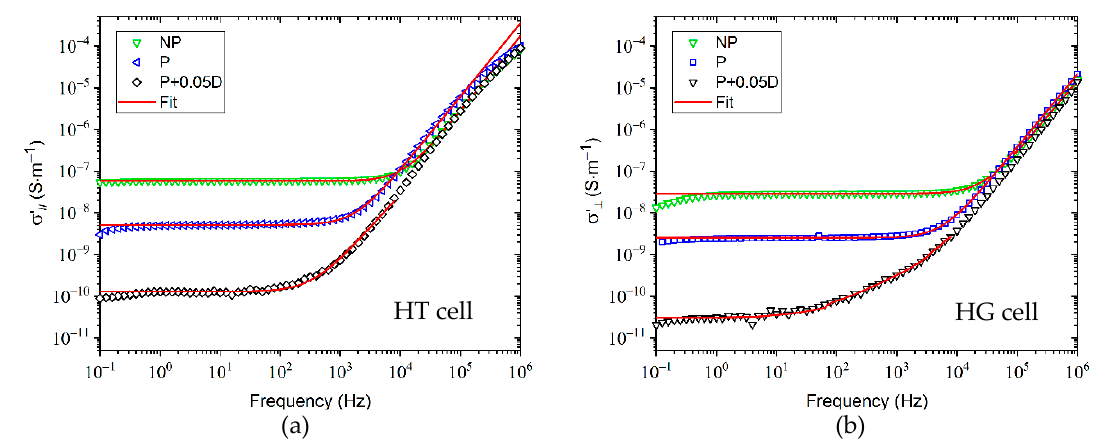
Figure 4. Real part of the complex conductivity in ( a ) homeotropic and ( b ) homogeneous alignments as a function of frequency of non-purified, purified, and DNP-doped (0.05 wt%) LC mixtures. The experimental data are represented by symbols and the red lines show the curves obtained applying Jonscher’s model. NP corresponds to non-purified; P is for purified; and P + 0.05D stands for LC mixtures doped with 0.05 wt% of DNPs.